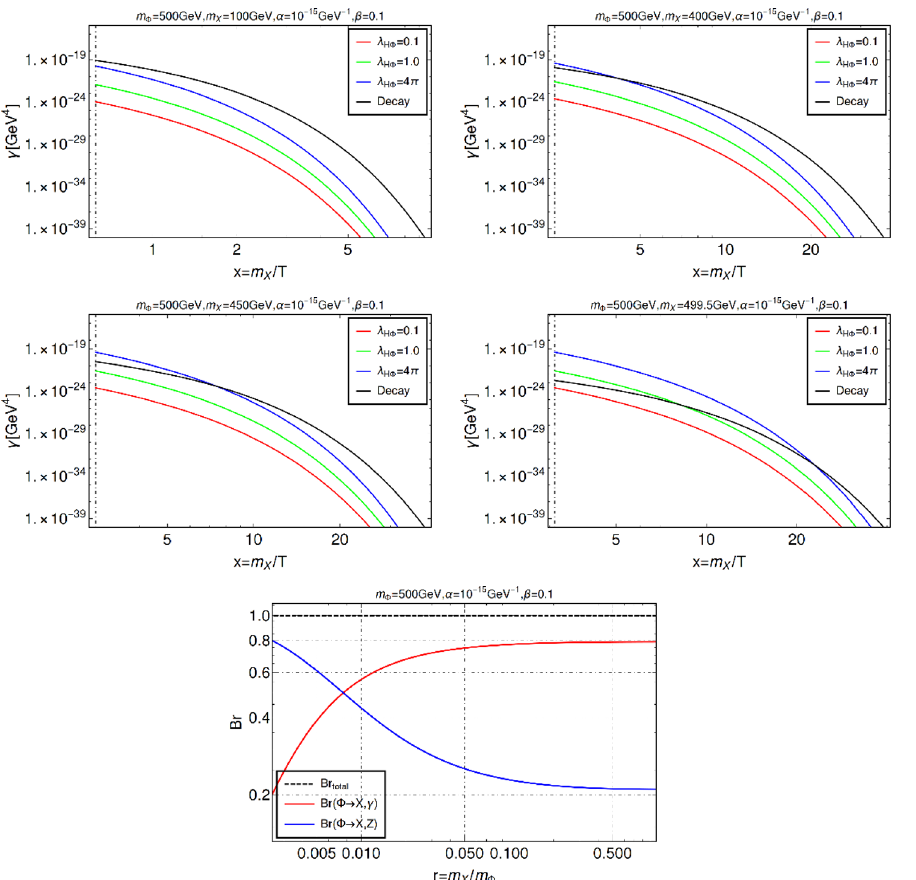
Figure 9 . Top panel: comparison of reaction densities due to annihilation (colorful lines) and decay (shown in black) after EWSB. Contributions of two annihilation channels are shown: h, Φ → X, Z via Z boson mediation in t -channel and h, Φ → X, γ ( Z ) via Φ mediation in s -channel. All states are assumed to be massive. The amplitudes for h, Φ → X, γ ( Z ) channel are proportional to the portal coupling λ H Φ that is being varied in the plots. The choice of parameters is specified in